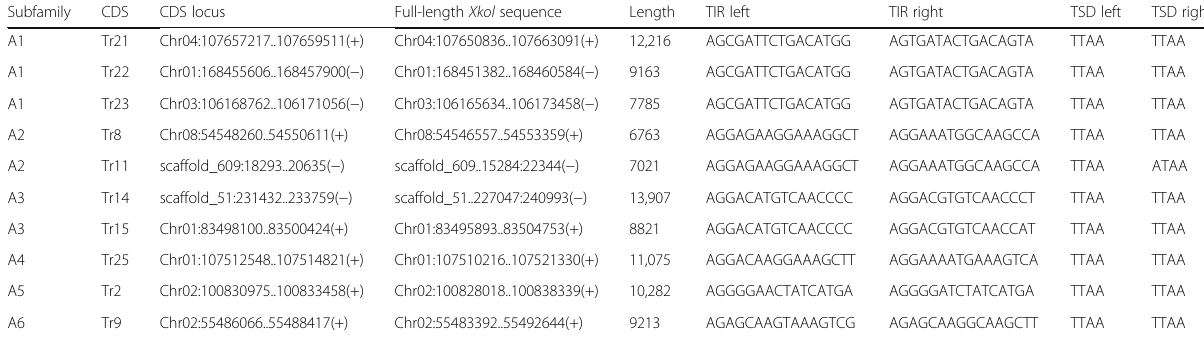
Table 5 Full-length X. tropicalis XKol